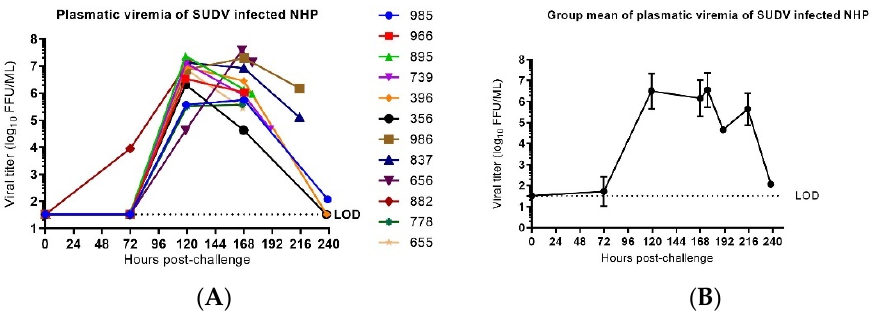
Figure 10. Plasmatic infectious virus in SUDV-challenged NHP. ( A ) Plasmatic viral infectious load in individual SUDV-challenged animals versus time. Viral load represents the mean of two titration assay replicates and are expressed in logarithm decimal FFU/mL. Time course is expressed in hour(s) post-challenge (pc). LOD is the limit of detection of the immunological detection plaque titration assay (=1, 52 log 10 FFU/mL). ( B ) Group mean ± SD of SUDV infectious viral load versus time. Time course is expressed in days post-challenge (pc).